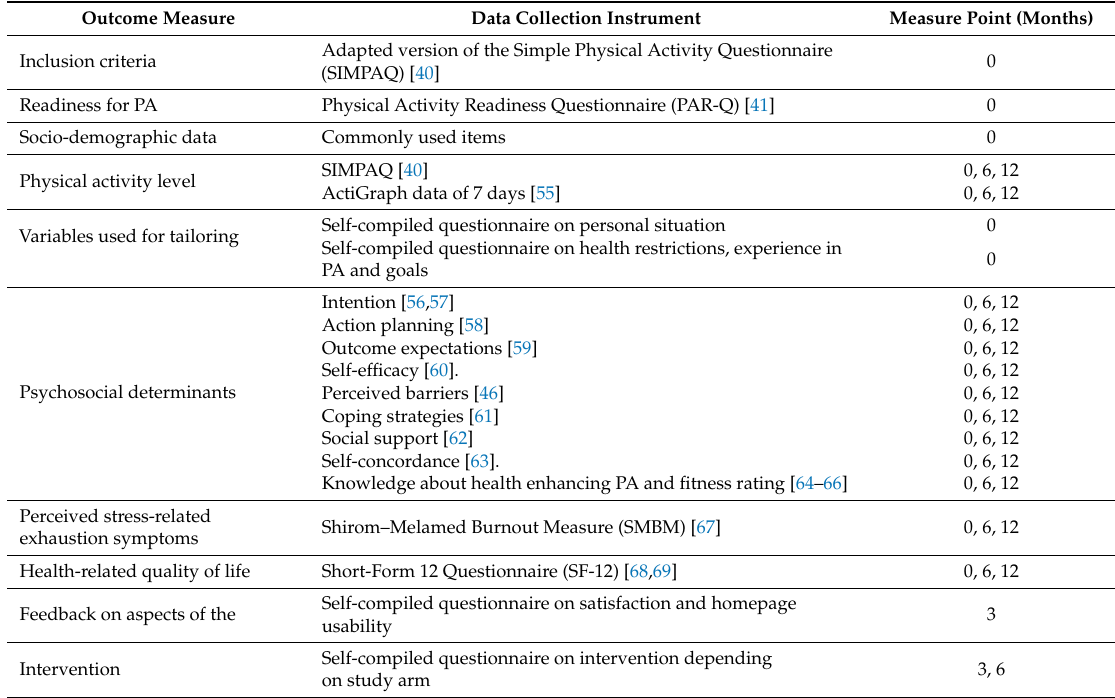
Table 4. Primary and secondary outcomes assessed in the Movingcall